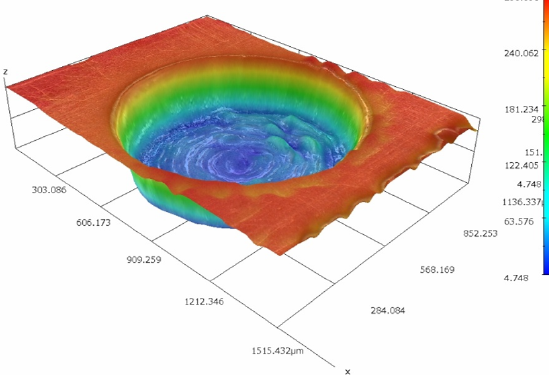
Figure 10: 3D profile of the first sample for trajectory No. 3.